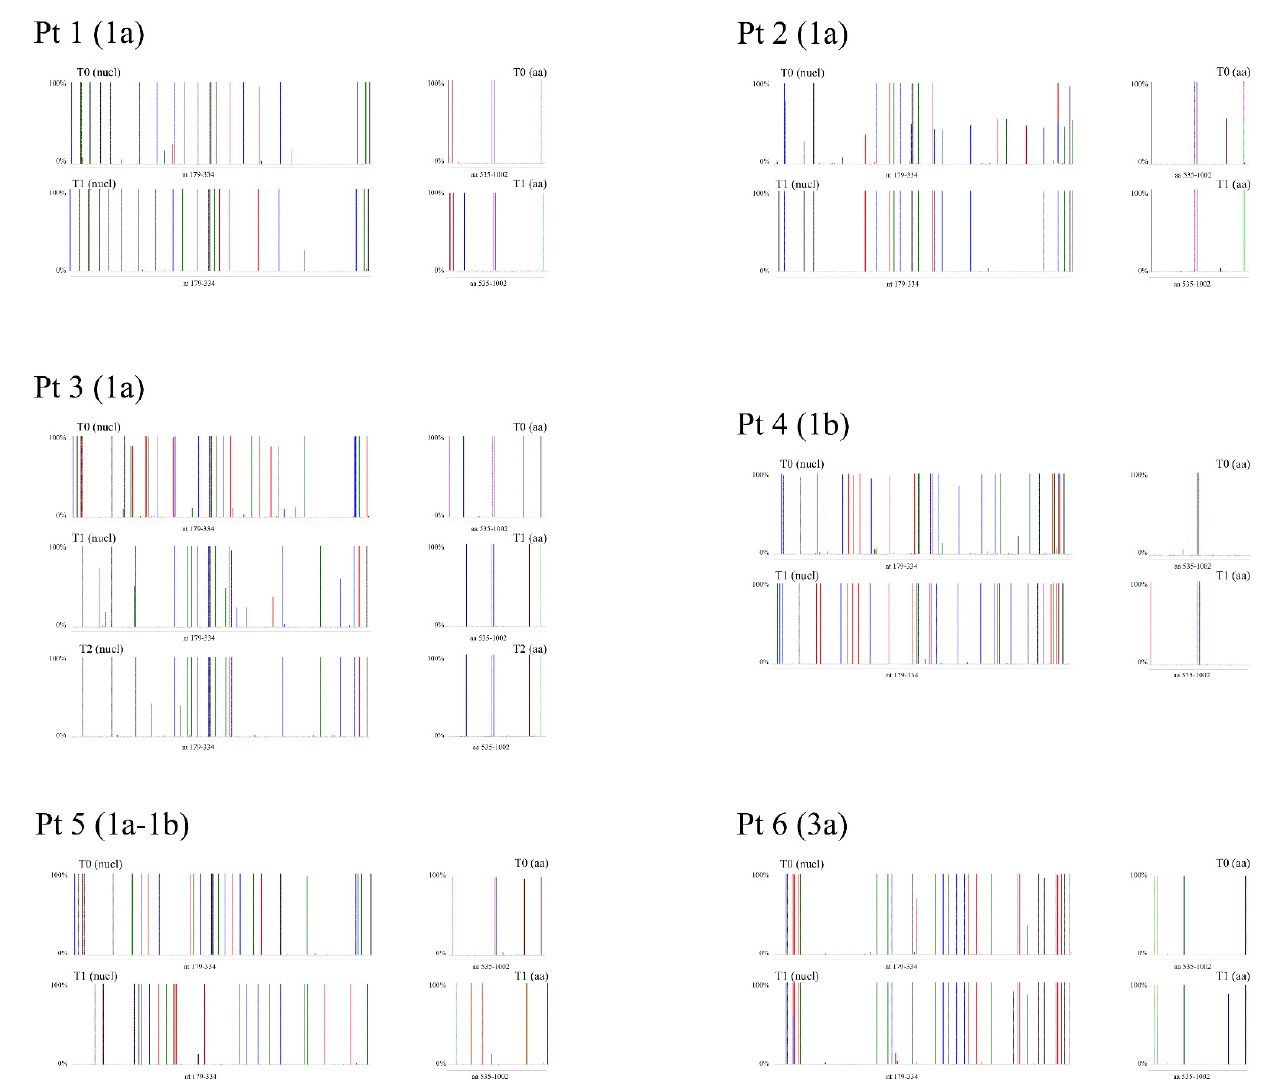
Figure 4. Graphic representing the frequency of nucleotide and amino acid substitutions detected at each tested time point for the six patients (Pt1–Pt6).